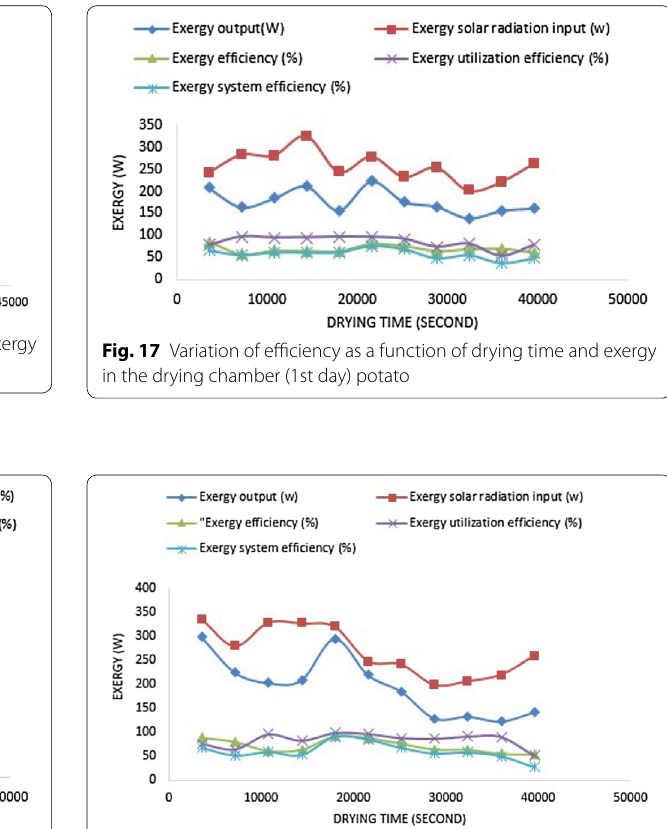
Fig. 18 Variation of efficiency as a function of drying time and exergy in the drying chamber (2nd day)